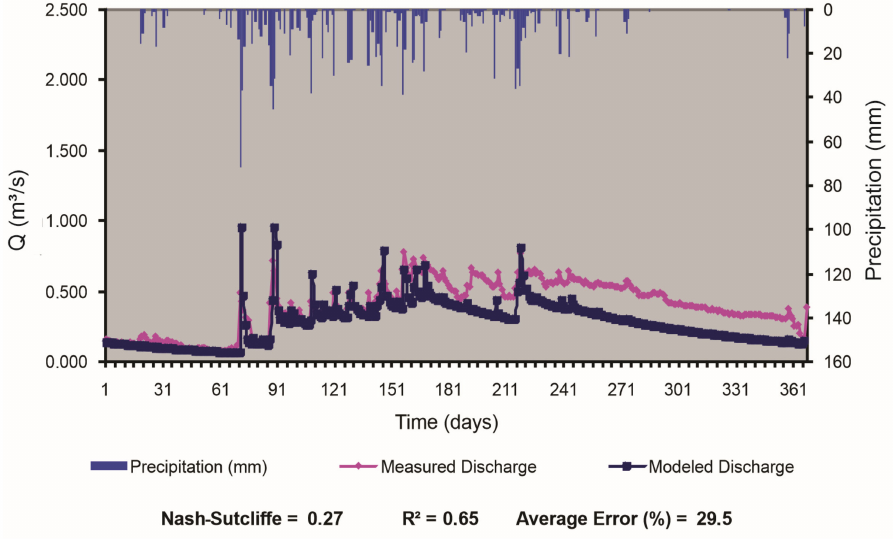
Figure 10. Measured versus modeled discharge